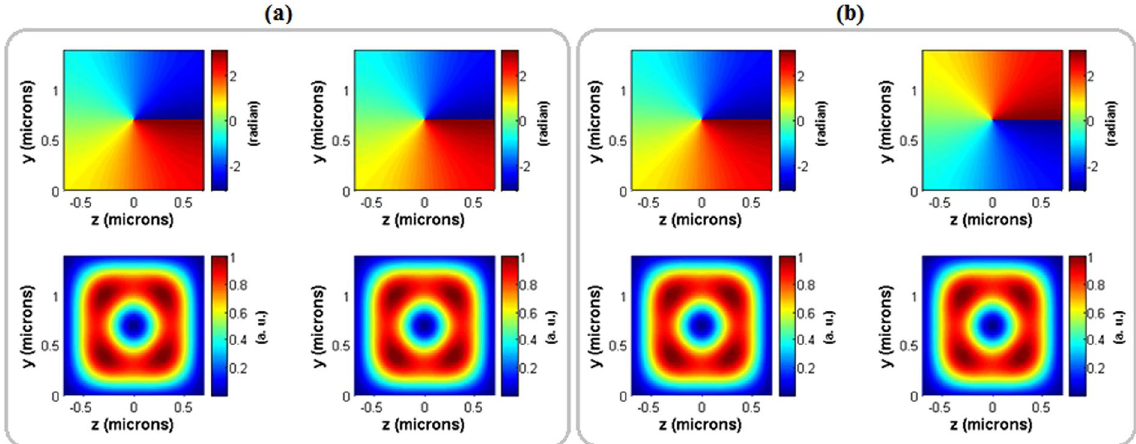
Figure 3. Left and right columns display the input and output phase patterns (top row) and power distributions (bottom row) of the horizontal polarized beam (| H 〉 ) before ( a ) and after ( b ) the applied external electric field,